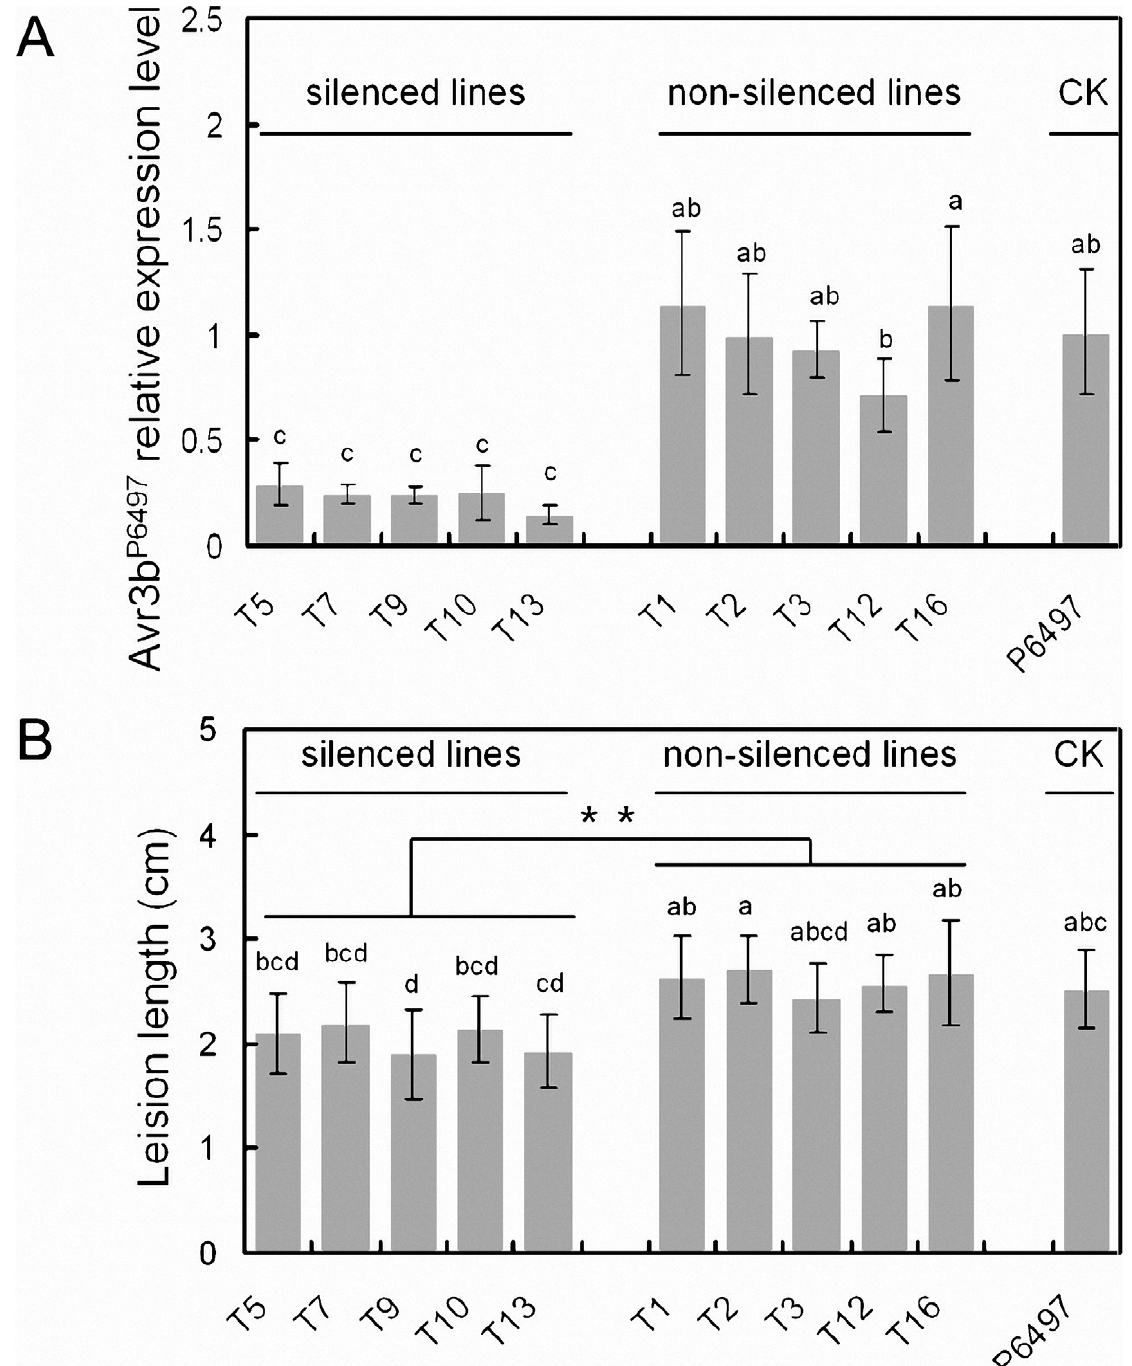
Figure 6. Transient silencing of Avr3b impaired P.sojae virulence on soybean. In vitro synthesized Avr3b dsRNA was introduced into P. sojae P6497, generating 16 lines. Avr3b transient transformants and recipient strain P6497 were examined for Avr3b transcript levels and virulence. RNA samples were extracted at the germinating cyst stage. ( A ) Avr3b transcript levels were determined by Real-time PCR using P. sojae actin transcripts as a reference and then normalized to the wildtype (P6497). Bars represent standard errors from 2 independent RNA isolation and Real- time PCR replicates. Letters indicated above each column represent statistical significance based on Duncan’s multiple range test (p , 0.01). ( B ) The disease lesion lengths in etiolated soybean hypocotyls (susceptible cultivar Williams) infected with zoospores of Avr3b transient transformants and P6497 at 36 hpi. Means and standard errors from at least 10 measurements are shown. Two statistical tests was used. The letters indicated above each column represent statistical significance based on Duncan’s multiple range test (p , 0.01). The asterisk indicates statistical significance based on student’s t-test (p , 0.01).